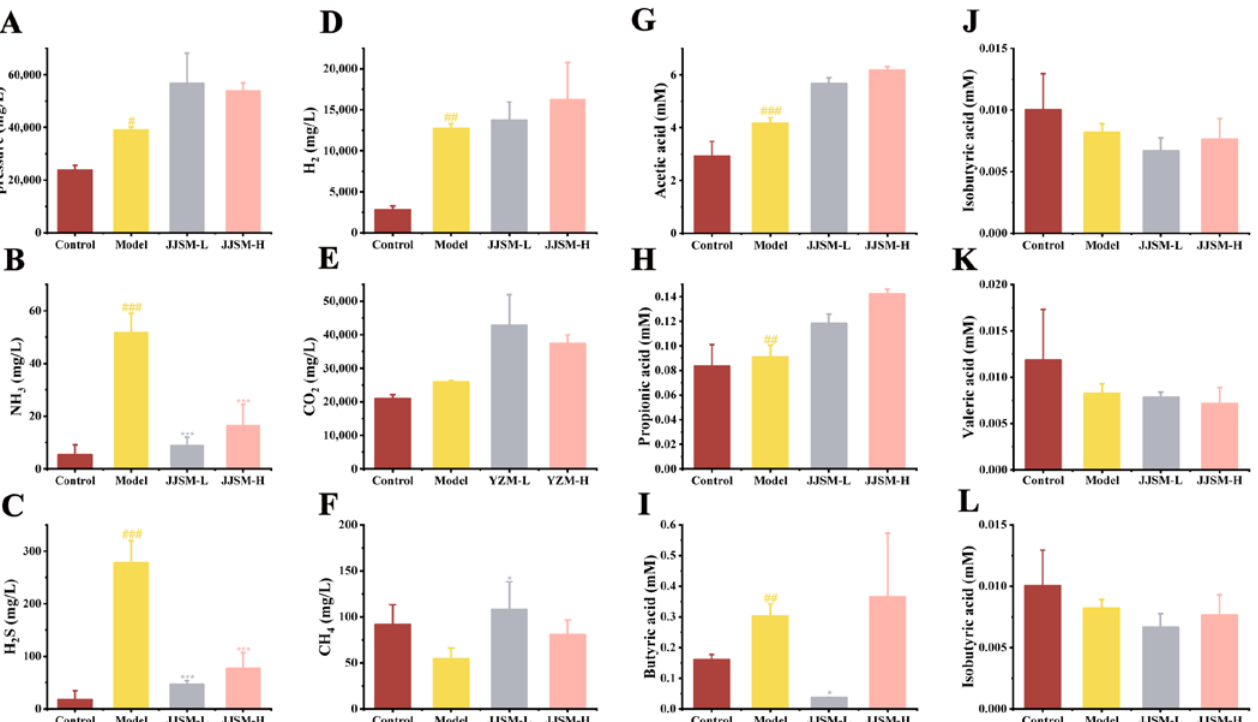
Figure 2. Gas production. ( A ) The pressure that remains after fermentation. Schizonepetae Spica results in increased pressure after incubation; ( B ) NH 3 ; ( C ) H 2 S; ( D ) H 2 ; ( E ) CO 2 ; ( F ) CH 4 . The x-axis displays the sample groups, the y-axis displays gas amount, the gas abundance value is the mean of three biological replicates, and the error bars reflect the 95% confidence intervals. Short-chain fatty acid (SCFA) production. ( G ) Acetic acid; ( H ) Propionic acid; ( I ) Butyric acid; ( J ) Isobutyric acid; ( K ) Valeric acid; ( L ) Isovaleric acid. Data are presented as the mean ± S.D. # p < 0.05 vs. control, ## p < 0.01 vs. control, ### p < 0.001 vs. control, * p < 0.05 vs. model, *** p < 0.001 vs. model. M: molecular weight of gas.